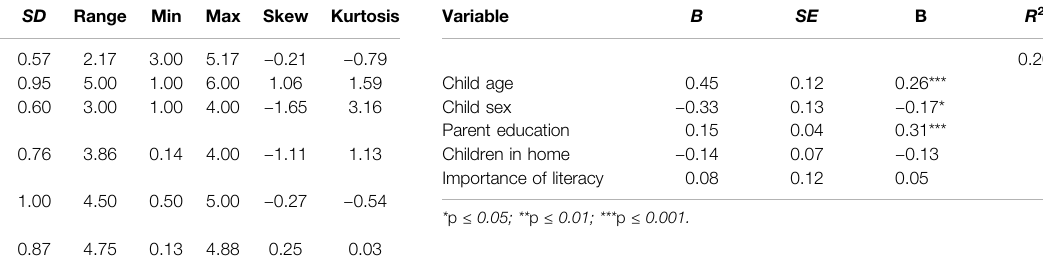
TABLE 1 | Descriptive statistics of covariates, child outcomes, and home environment.